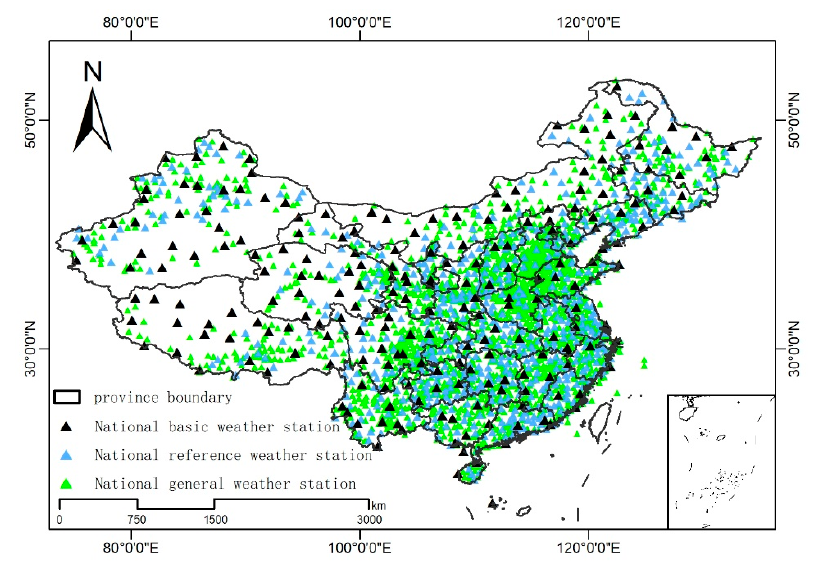
Figure 2. Study area and weather stations in China.